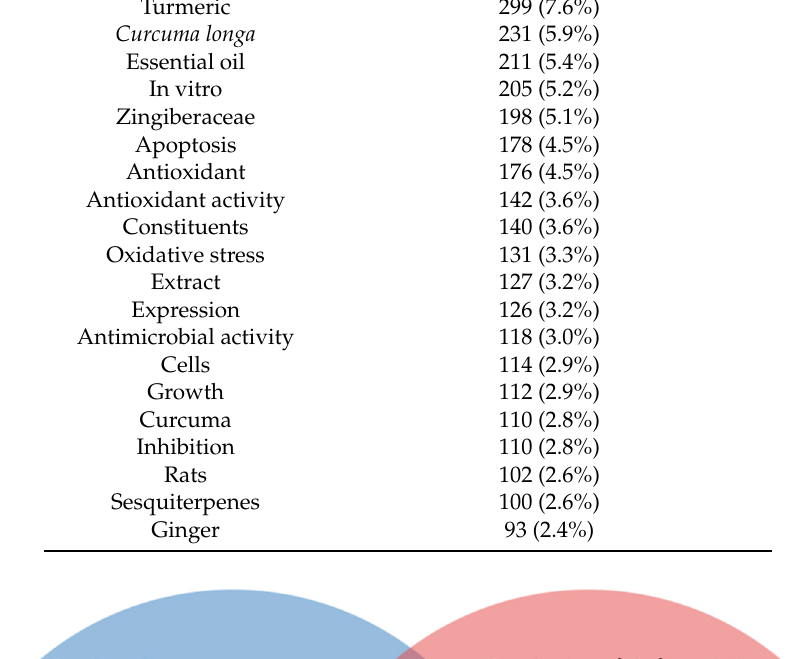
Table 6. The top 20 recurring keywords from publications mentioning C. longa or turmeric but not curcumin.